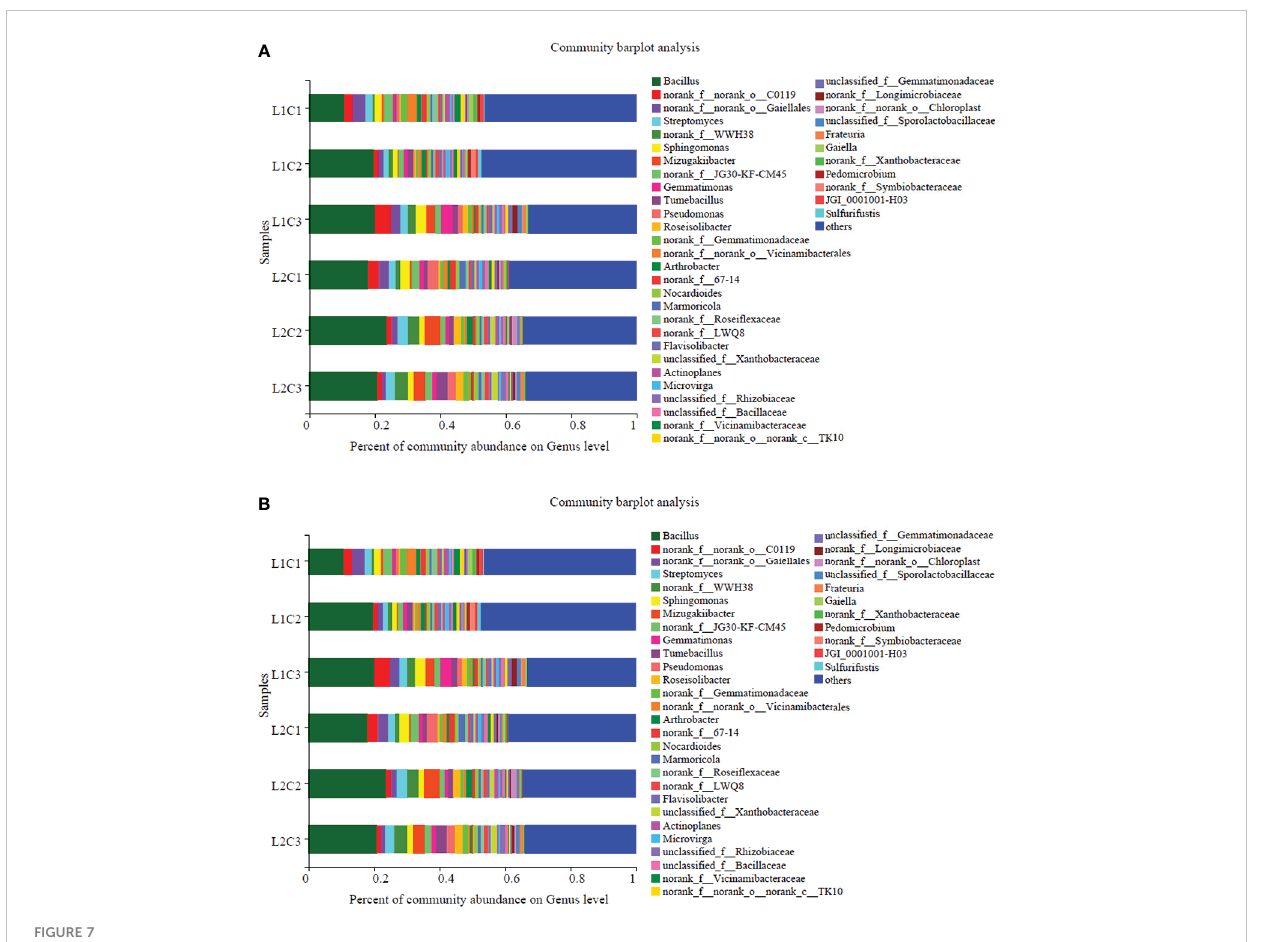
FIGURE 7 Taxonomic level of soil bacteria. (A) Spring (B) Autumn.